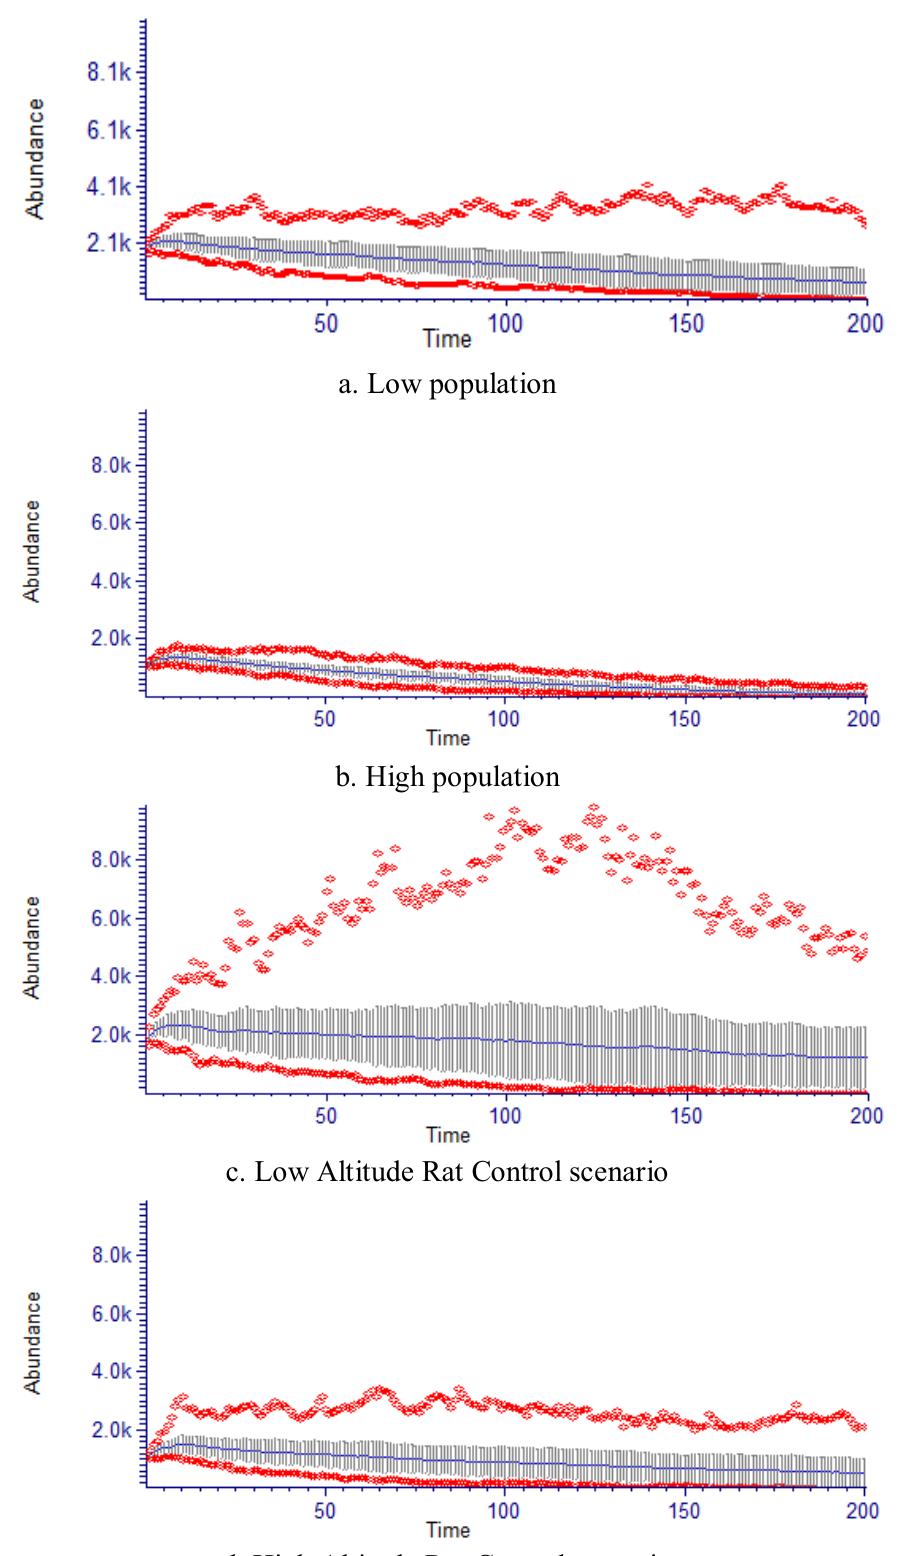
Figure 7. RAMAS probability trajectory summaries for low altitude, high altitude and associated rat control scenarios of H. canterburyana for 200 years. Line is mean value with 1 vertical standard deviation bars. Red diamonds are minimum and maximums. Models were run for populations in one